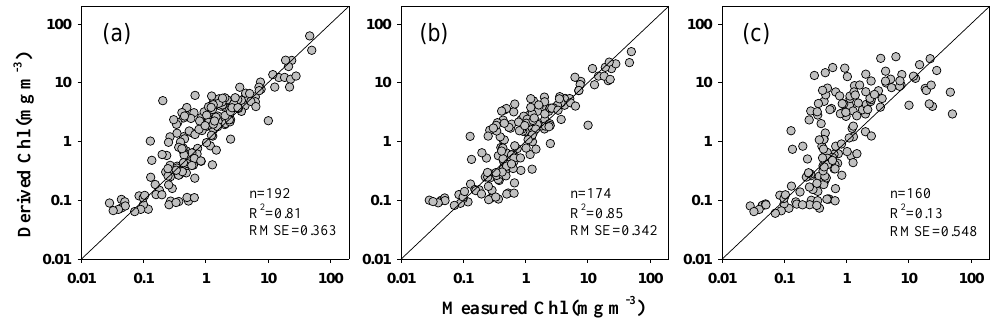
and field measured R rs